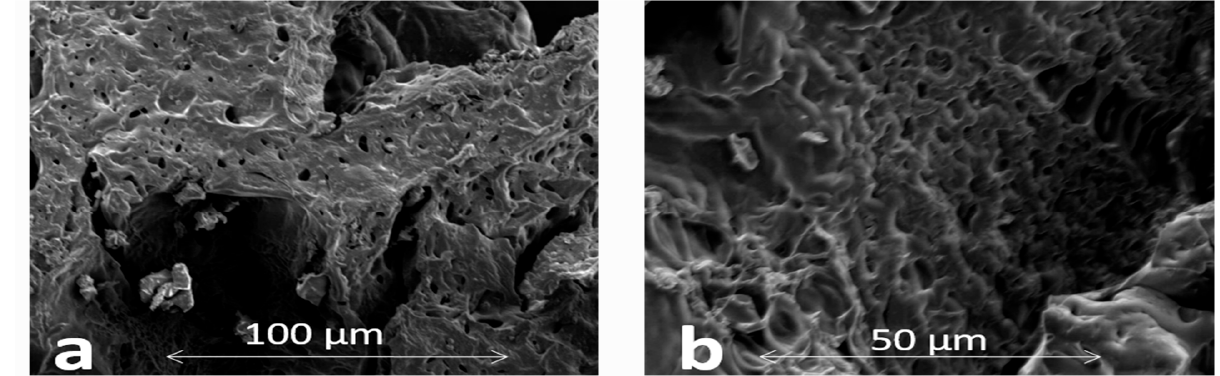
Figure 5. Surface ( a ) and cross-sectional ( b ) SEM images of BSG-co-poly (AA)-loaded hydrogel.